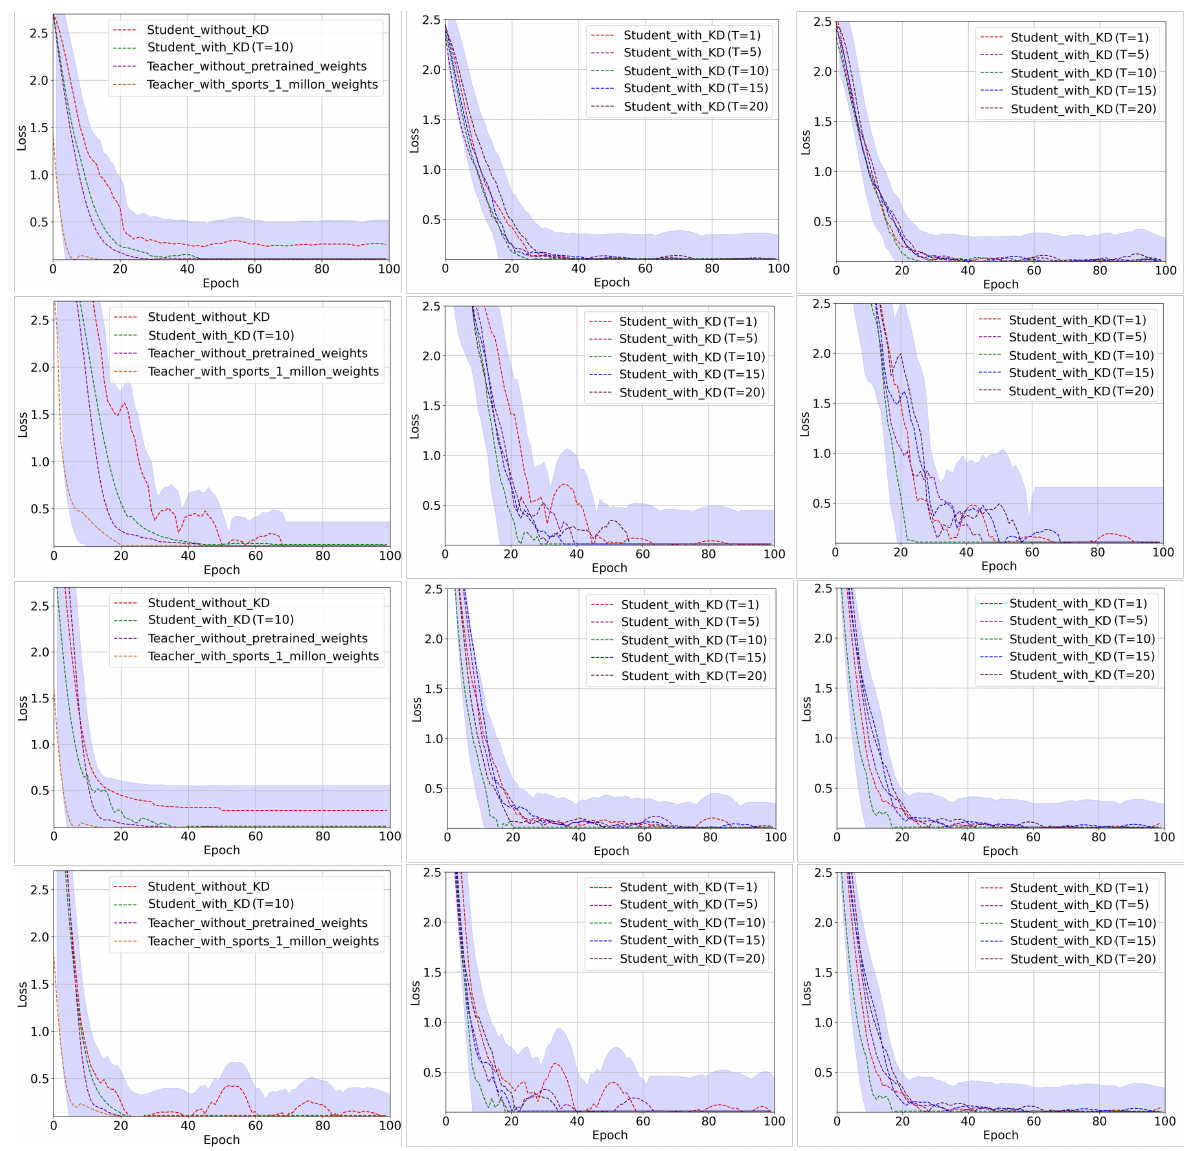
Figure 5. The visual overview of training histories for teacher and student models trained with different settings. The first, second, third, and fourth row represent the average training loss of teacher and student model with different settings over UCF11, HMDB51, UCF50, and UCF101 datasets,